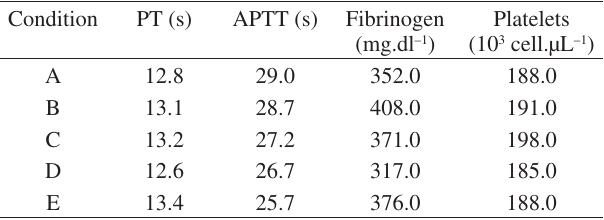
Table 1. Prothrombin (PT) and activated partial thromboplastin times and densities of fibrinogen and platelets in blood samples freshly collected (A) and after 2.5 hours in contact with glass slides as-received (B), exposed to SF6 plasma (C) and coated by PECVD of heparin/isopropanol (D) and heparin/ HMDSO (E) solutions.